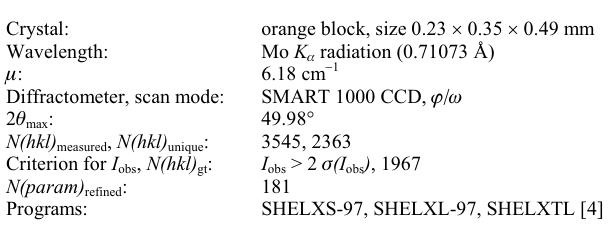
Table 1. Data collection and handling.